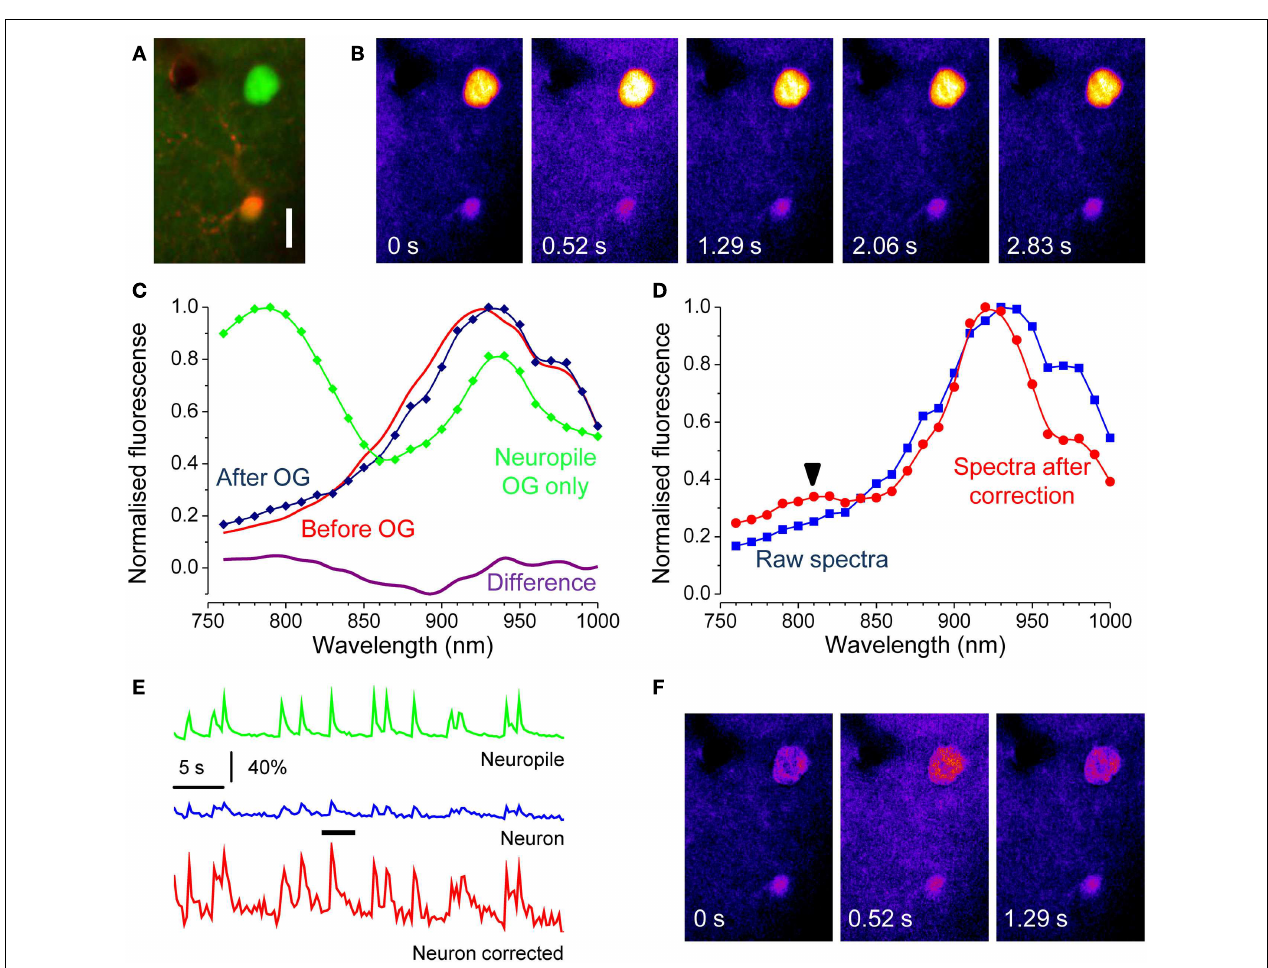
after correction for scattering and absorption.The raw spectra does not allow to detect the OG signature by linear decomposition, in fact, the fit returns α =− 0.05 and β = 1.00. After correction, the presence of the OG spectral signature becomes obvious and that is reflected in the values of the α and β parameters: α = 0.11; β = 0.80. (E) Time course of the Ca 2 + changes occurring during epileptiform activity measured for the neuropile, that returns the average activity of the local circuit, and for the tagged neuron.The response computed from the raw data is very small, due to the strong Ca 2 + insensitive offset. Equation 8 and 9 were used to correct for the offset, and the resulting Ca 2 + oscillations are now comparable with the responses recorded in the neuropile (red trace). (F) The Ca 2 + insensitive background can be subtracted from the imaging sequence to provide a correct representation of the Ca 2 + dynamics. Here, the Ca 2 + oscillations of the soma are much more